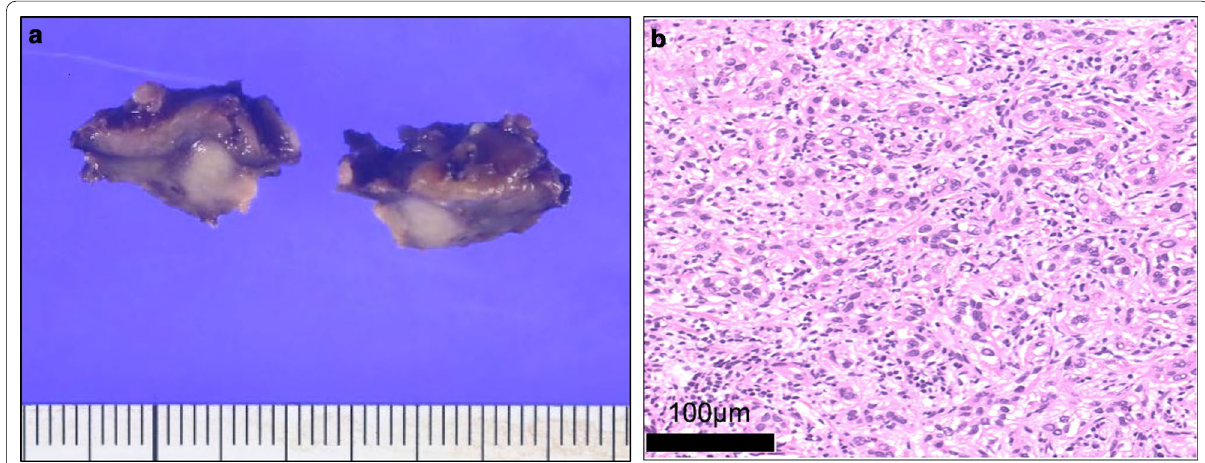
Fig. 3 Histopathological examination of the resected specimen. a Macroscopic examination shows a white, encapsulated solid tumor, 10 mm in maximum diameter. Surgical margins are negative, but 0 mm. b Microscopic examination shows irregular, cord-like pattern cells with eosinophilic cytoplasm and nuclear atypia. The pathological diagnosis is well-to-moderately differentiated hepatocellular carcinoma (hematoxylin and eosin staining; ×